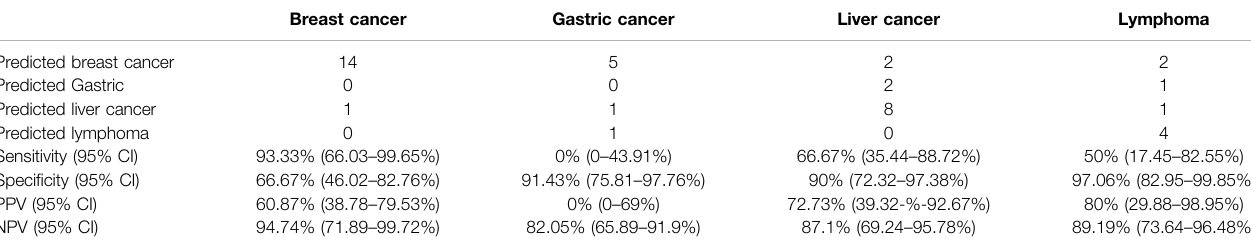
TABLE 2 | The performance of the tumor tissue origin classi fi er for breast cancer, gastric cancer, liver cancer, and lymphoma. Breast cancer